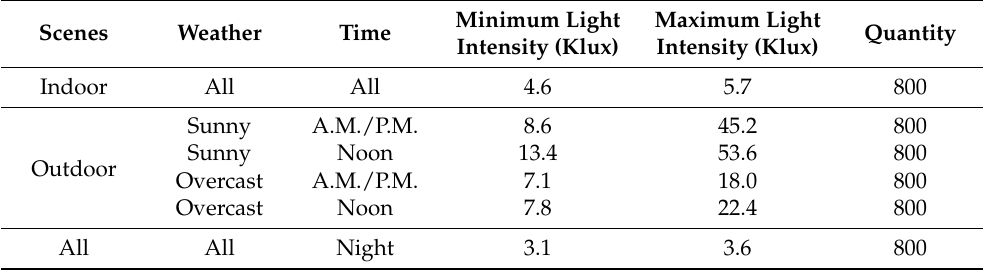
Table 3. Collection of CP data in